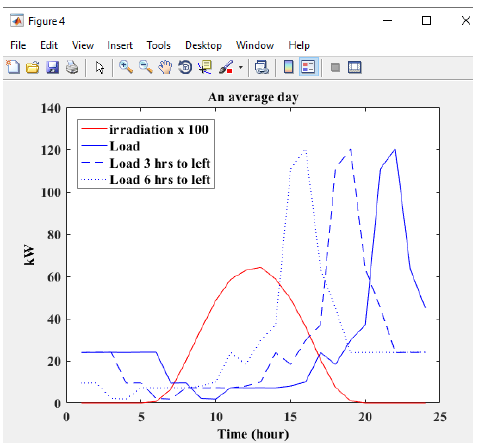
Figure 9. Battery size vs PV Array size causing Isodepth of equal cost NPC in black up to 2000